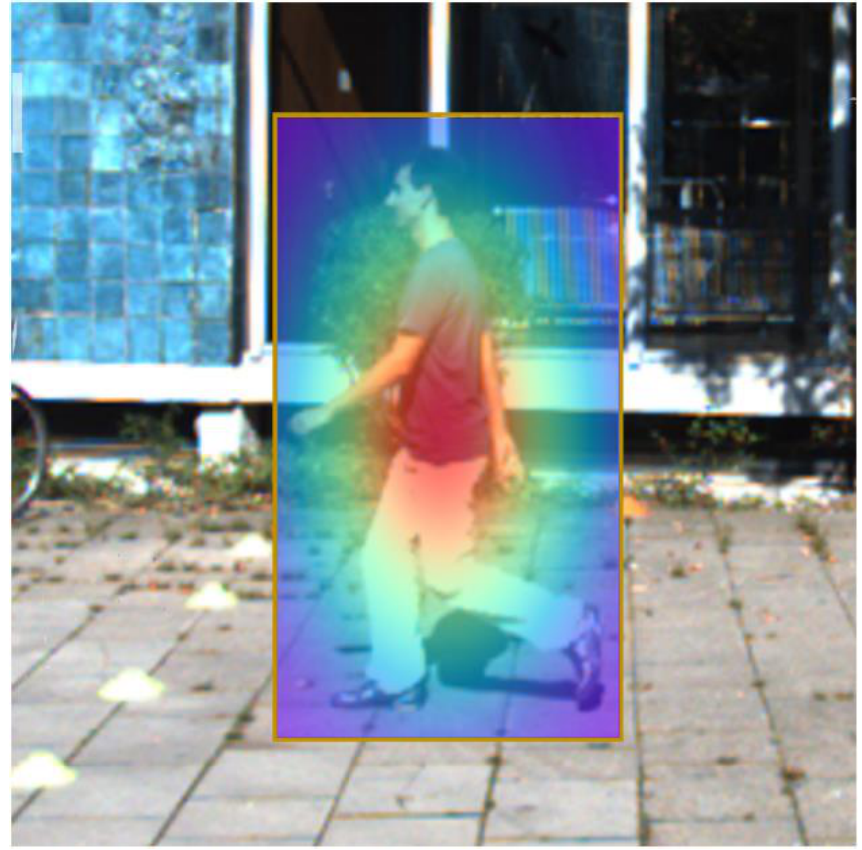
Figure 6. Aspect-aware Gaussian kernel in the traffic object. The value of the center point of the image is equal to the maximum value of 1.